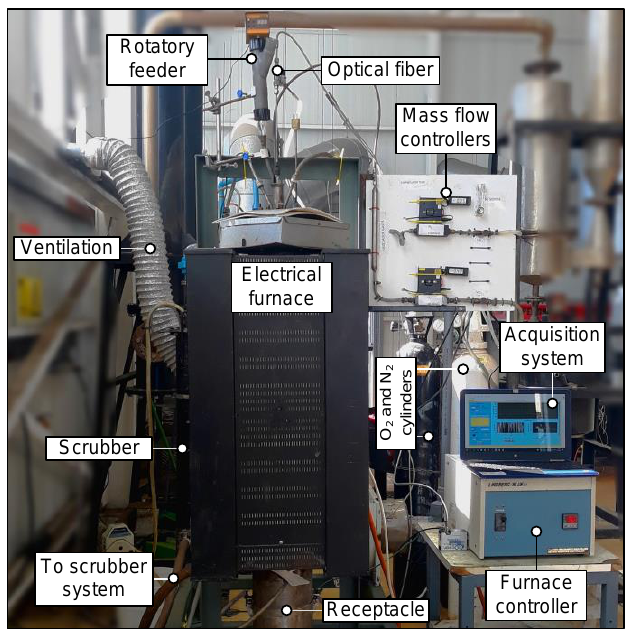
Figure 1. Experimental setup for combustion experiments.